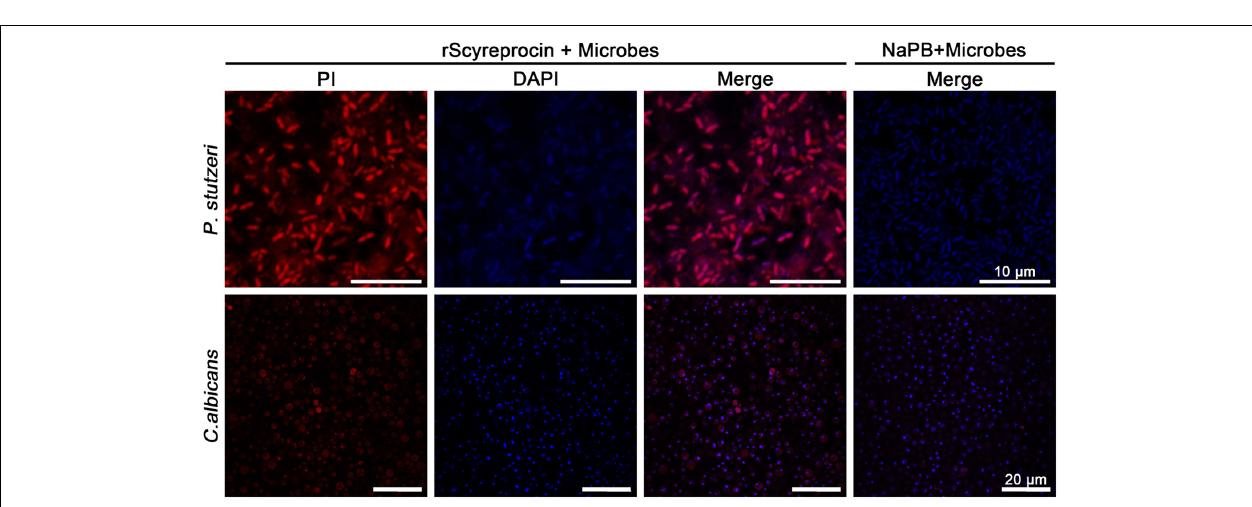
FIGURE 5 | Effect of rScyreprocin on the membrane integrity of Pseudomonas stutzeri and Candida albicans . Exponential phase microbial cells of P. stutzeri and C. albicans were resuspended in culture media supplemented with NaPB (control) or rScyreprocin (8 µ M) for 30 min. The samples were supplemented with PI and observed using a confocal laser scanning microscopy. For the microbes treated with NaPB, only merged images are shown.